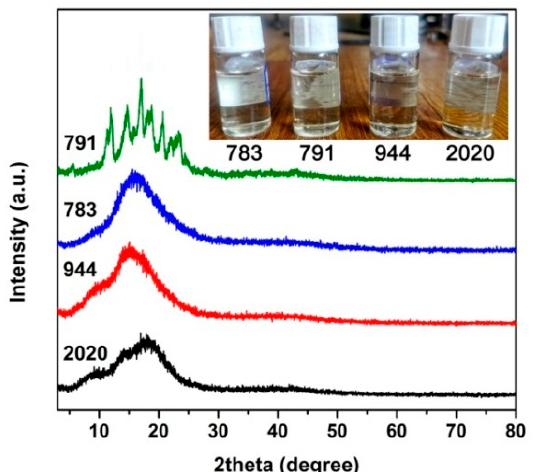
Figure 3. XRD patterns of hindered amine light sensitizer (HALS) compounds. (Insert: solubility of HALS in DMAc at a solid content of 10 wt%).